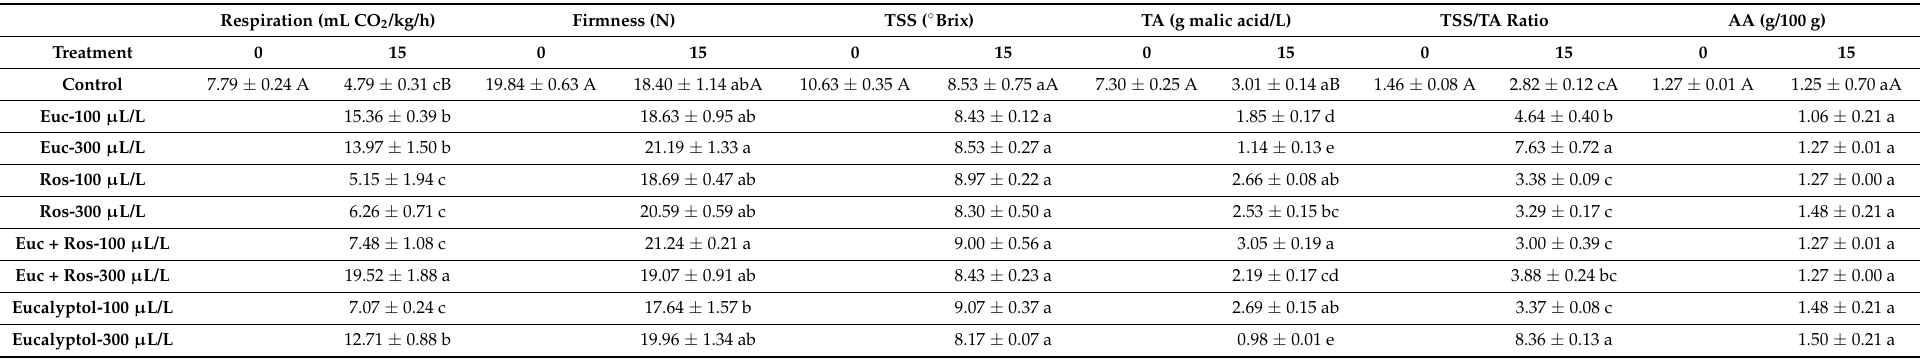
Table 1. Effects of eucalyptus EO (Euc), rosemary EO (Ros), their 50:50 mixture (Euc + Ros) and eucalyptol on quality attributes of inoculated with P. expansum apple fruits stored at 7 ◦ C for 8 days and subsequently at RT up to 15 days.